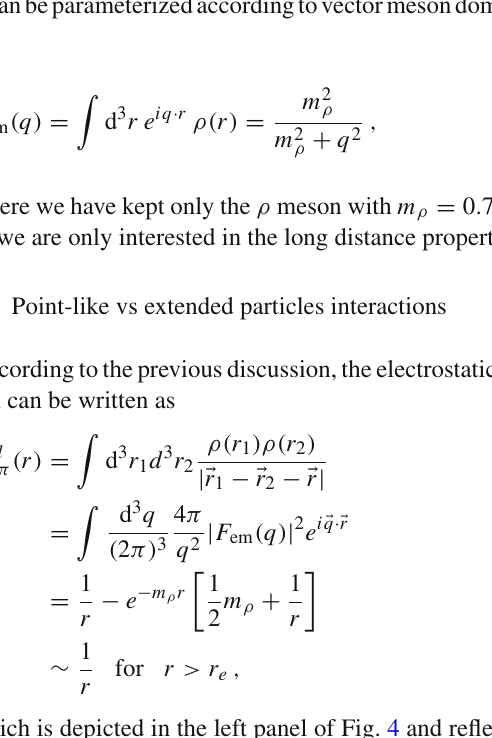
and the chiral 2 π exchange potentials V ππ at threshold addition, we also plot the energy dependence case (red-dashed), which leads to a divergent value at r →